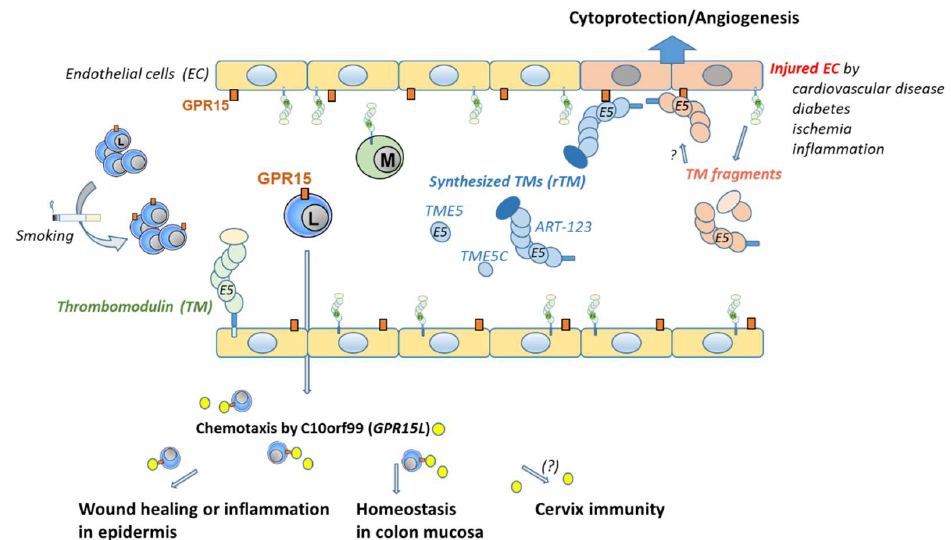
Figure 3. Distribution and binding of GPR15 by ligands in a blood vessel. GPR15 is expressed on endothelial cells (ECs) and on subtypes of lymphocytes. The frequency of GPR15+ lymphocytes can be increased by chronic cigarette smoking. If and how the GPR15 level on ECs can be influenced remains elusive. There are two different ligands for GPR15. One ligand, named C10orf99, is linked to binding on lymphocytes. It is found outside the vessel mainly in the skin, colon, and cervix. C10orf99 is responsible for chemotaxis of GPR15+ lymphocytes that are involved in wound healing or inflammation in the epidermis or homeostasis in the colon mucosa. Its role in cervix mucosa remains elusive. The second ligand is linked to thrombomodulin (TM) and ECs. TM is ubiquitously expressed on the luminal surface of ECs. Synthesized recombinant soluble fragments of TM (rTM), such as ART-123, TME5, and TME5C, were found to bind GPR15. rTM binds to GPR15 via its C-loop of the fifth epidermal growth factor-like region. TM expression decreases upon EC injury [30] and fragments are found in plasma. Binding of these natural fragments to GPR15 could be assumed but has not been confirmed. Binding of TM to GPR15 on ECs is cytoprotective and proangiogenic. ART-123 recombinant human soluble thrombomodulin, C10orf99 chromosome 10 open reading frame 99, EC endothelial cells, GPR15 orphan G protein-coupled receptor 15, L lymphocyte, M monocyte, TM thrombomodulin, TME5 fifth epidermal growth factor-like region of TM, TME5C C-loop of